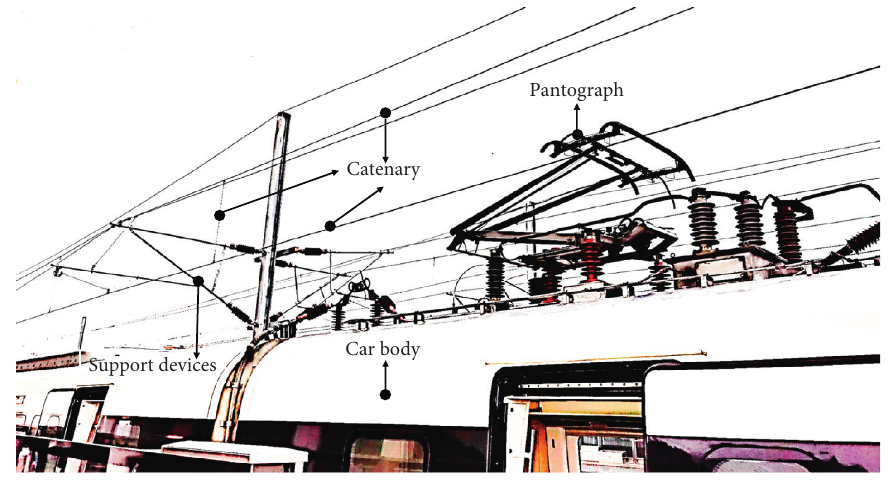
Figure 1: Pantograph-catenary systems.